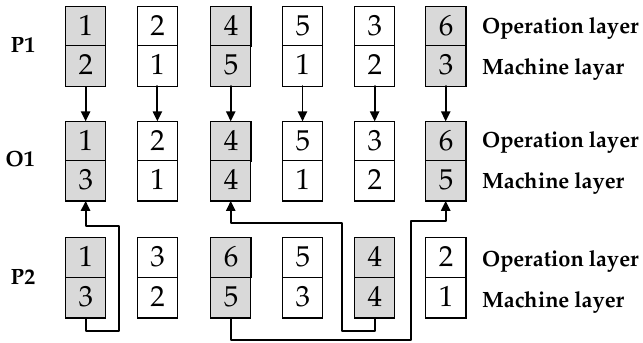
Figure 8. An example of crossover for machine layer.